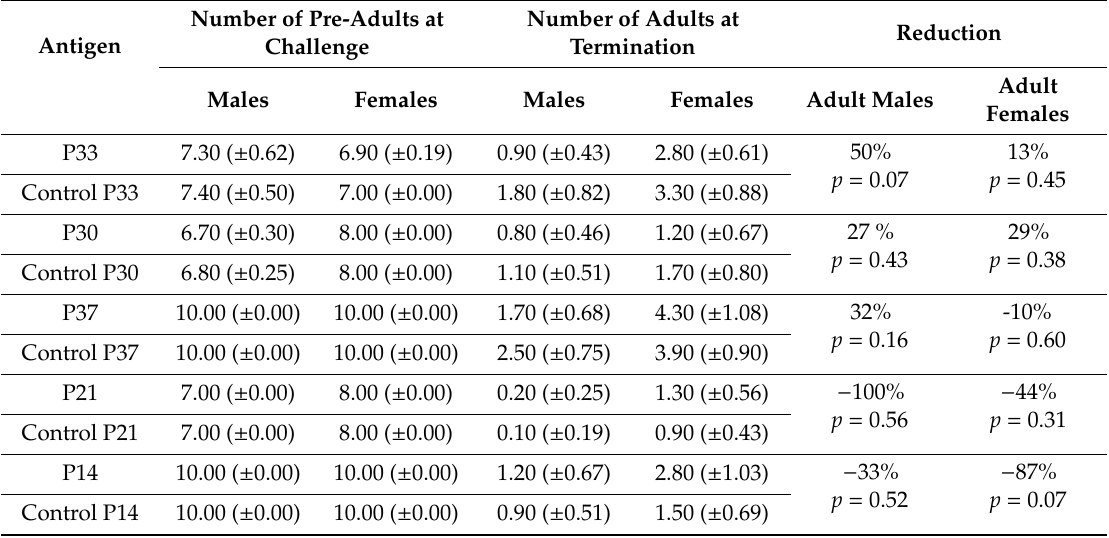
Table 4. E ff ect of vaccination on sea lice infestations in the single tank